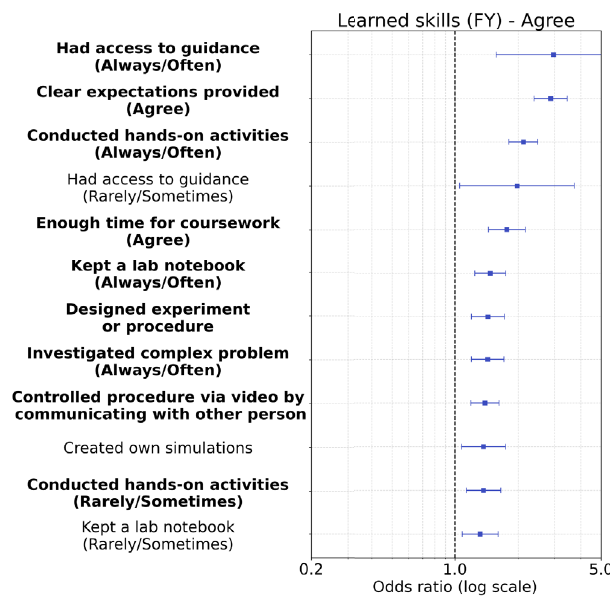
FIG. 8. Logistic regression odds ratios for students who agreed or strongly agreed that they learned lab skills in their course compared with all other students. Only variables with uncorrected p values less than 0.05 are shown. Bold variables are those that are statistically significant after the Holm-Bonferroni correction. Error bars show 95% confidence intervals. The odds ratios are on a log scale to make the positive and negative effects be of approximately equal size.